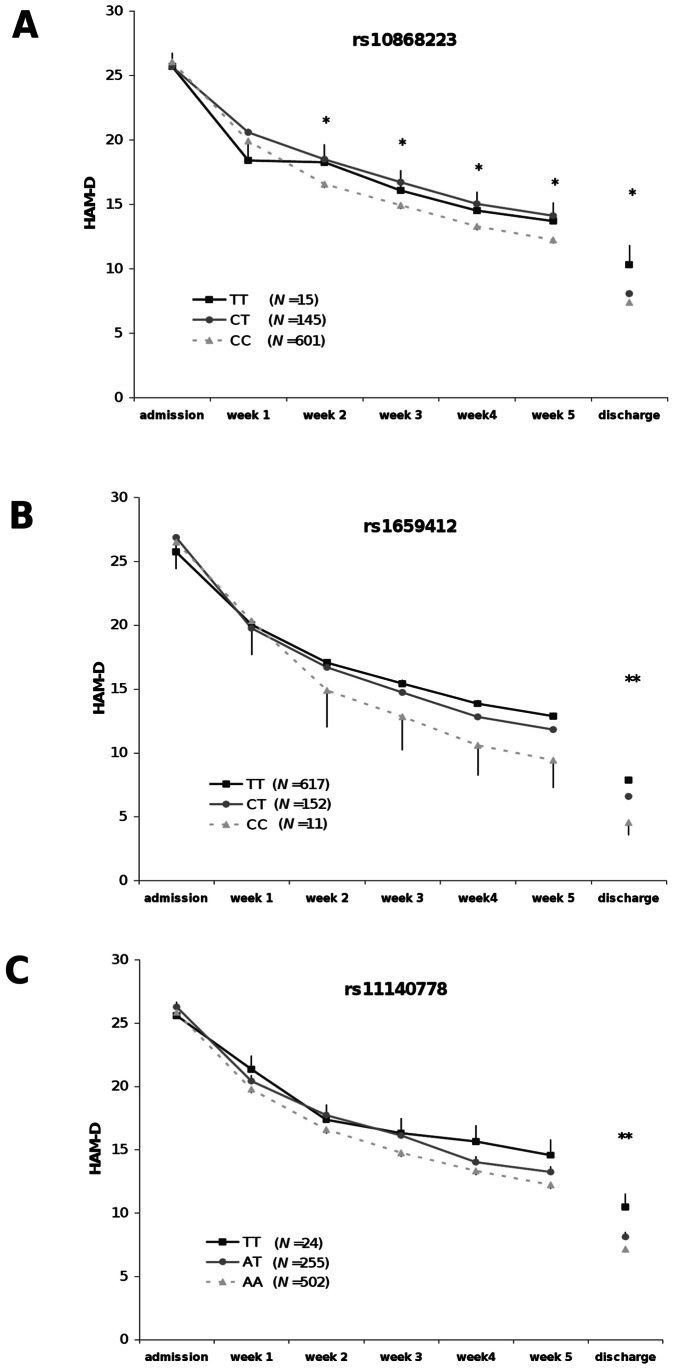
Development of HAM-D values during antidepressive treatment depending on the rs10868223 (A), rs1659412 (B) and rs11140778 (C) genotype (combined sample).Repeated measurements (Greenhouse-Geisser, age and sex as covariates) revealed significant interaction effects for rs10868223 (P = .007) and rs1659412 (P = .012), but not for rs11140778 (P = .645). Stars indicate significant between-subjects differences at different time points (*, p<.05; **, p<.01; GLM with age and sex as covariates). Error bars are standard errors of the means.